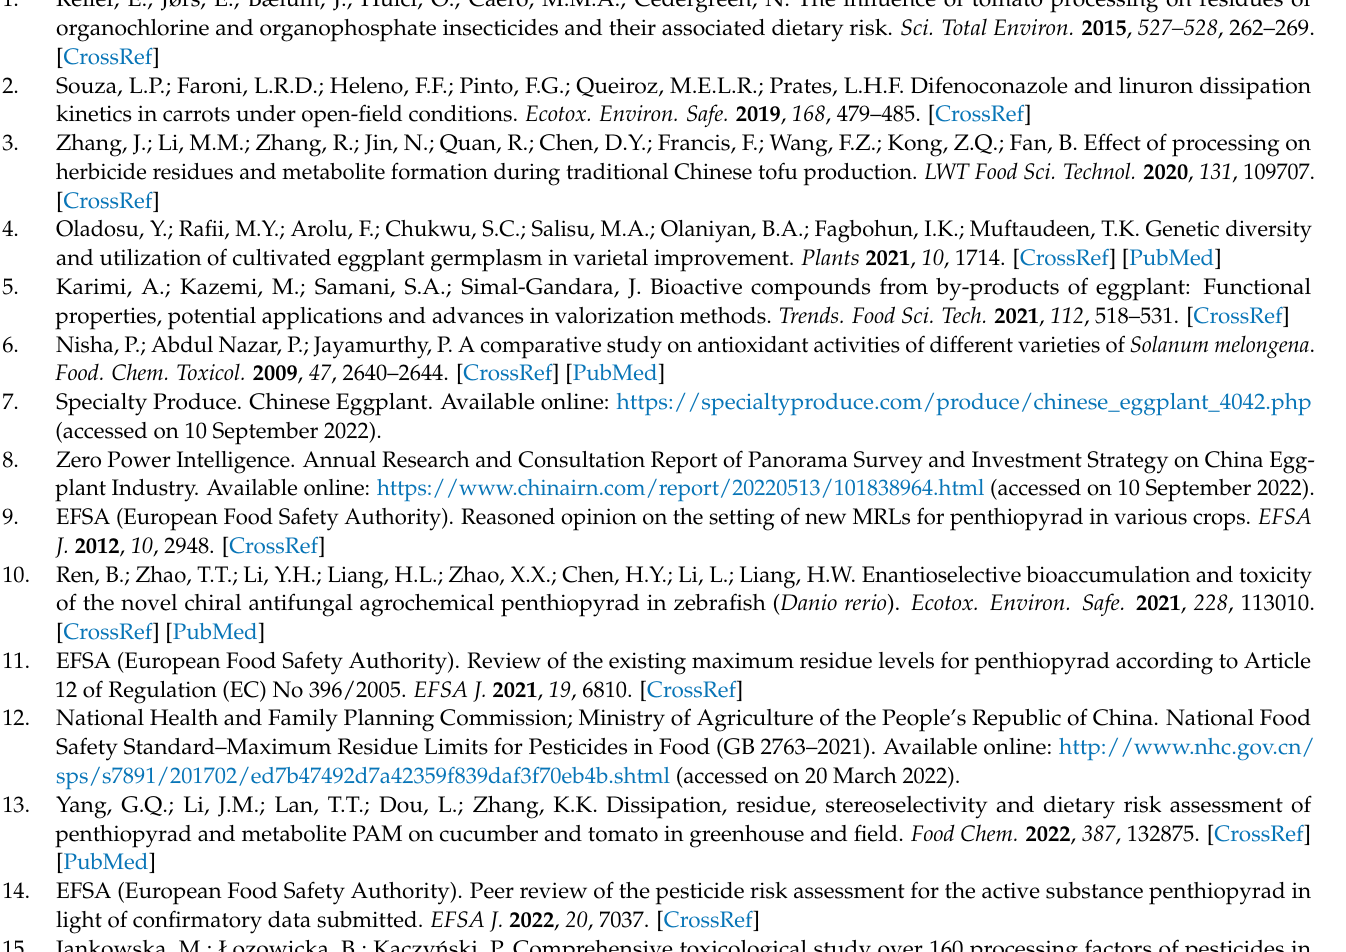
Table S7: Acute risk assessment of stereoisomeric, racemic and total penthiopyrad in eggplant under field conditions; Table S8: Chronic risk assessment of stereoisomeric, racemic and total penthiopyrad in eggplant under field conditions; Table S9: Reduction ratios (RRs) of penthiopyrad from eggplant under different household processing